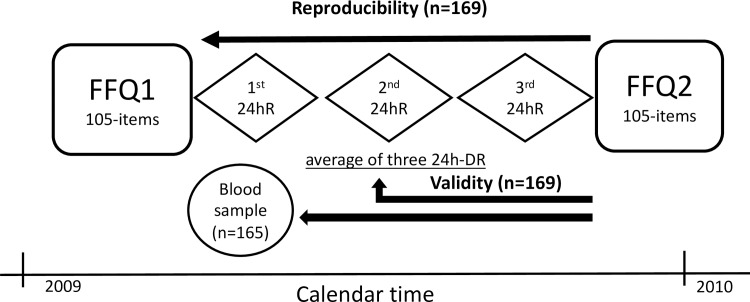
The design of the validation study among children aged 4–5 years of the INMA Project in Valencia, 2009–2010.FFQ, food frequency questionnaire; 24hDR, 24hour dietary recall.